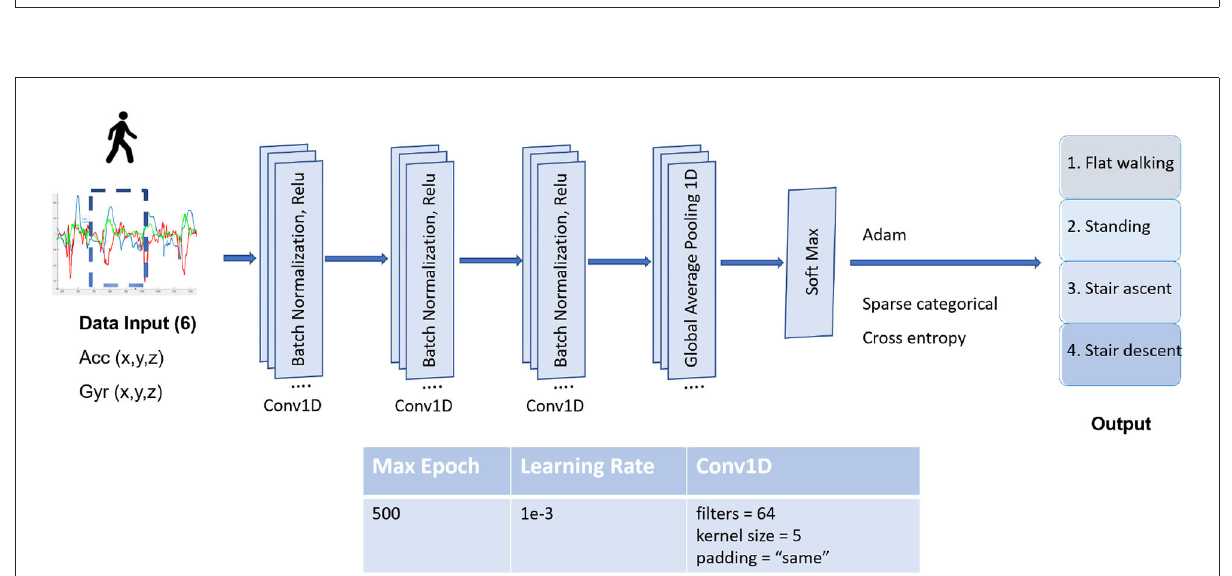
FIGURE6 The structure of the computational neural network (CNN) and its type and parameters. 1D convolution layer (Conv1D) indicates each input channel is one dimensional with 64 filters and a kernel size of 5. The Conv1D layers use a batch normalization (BN), and rectified linear unit (ReLU) is used as an activation